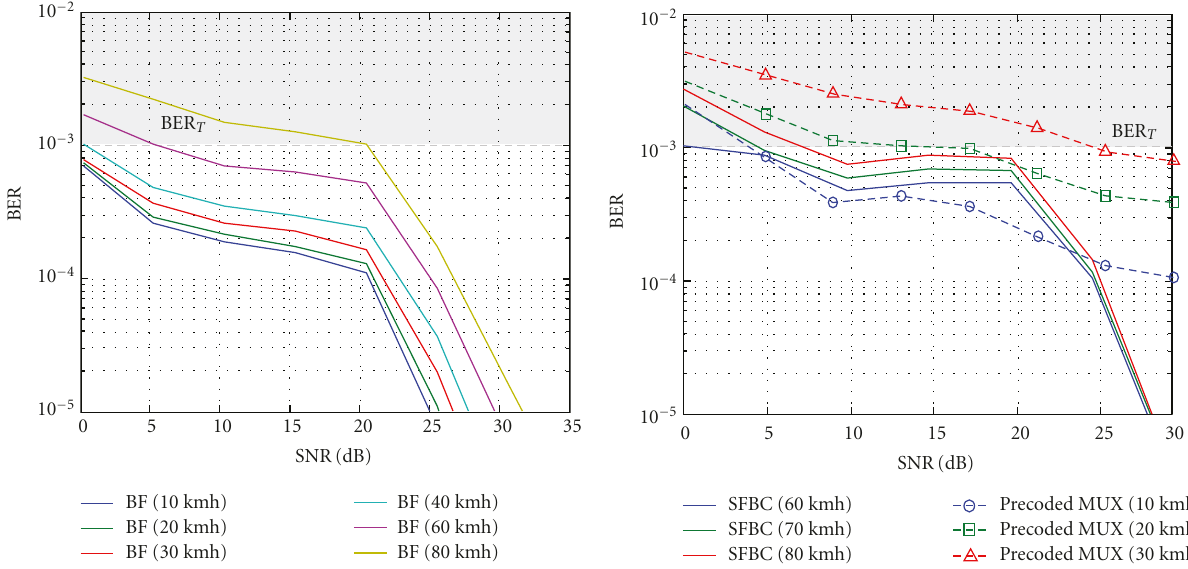
Figure 12: Evaluation of the maximum admissible user speed for di ff erent MIMO schemes under adaptive modulation.